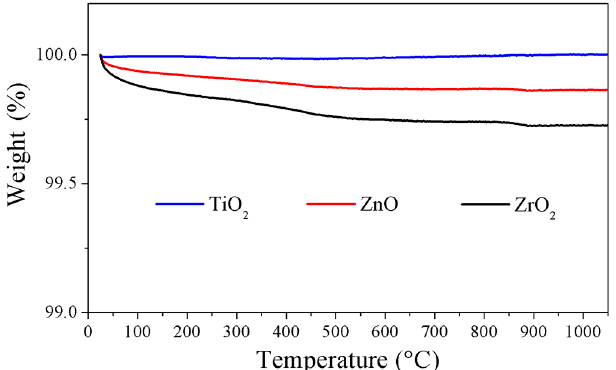
Figure 3. TGA analysis of the Er 2 O 3 -doped TiO 2 , ZnO, and ZrO 2 particles.